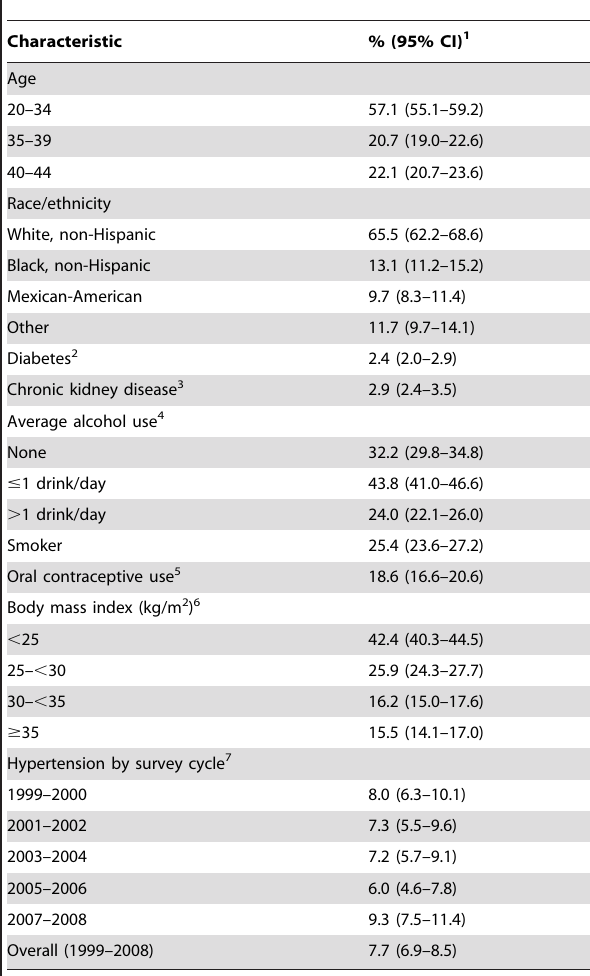
Table 1. Characteristics of reproductive aged women,